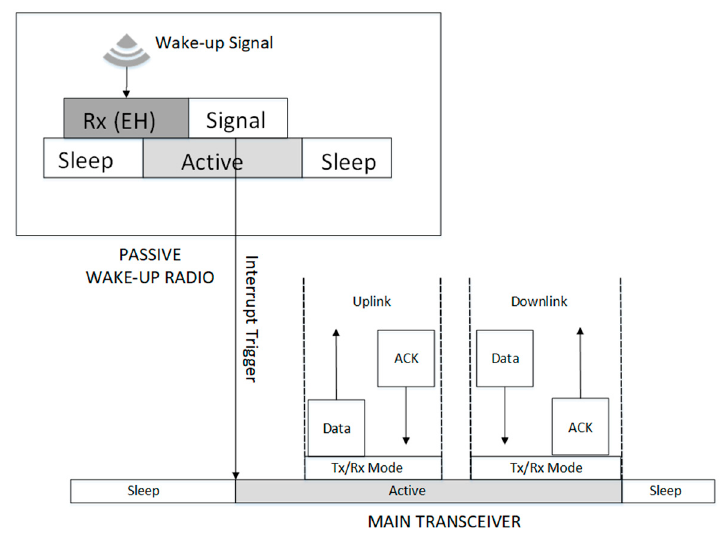
Figure 5. Passive wake-up reception process.